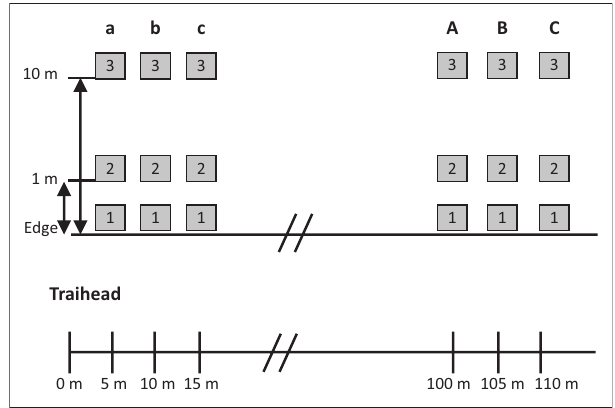
FIGURE 2: Experimental design of vegetation transect survey conducted in the Silvermine section of the Table Mountain National Park in order to investigate the distribution of invasive plants. Three 1-m 2 quadrats, each represented by a grey square, were sampled along a 10-m line transect. This technique was repeated at 5 m (a, b and c) and 100 m (A, B and C) from the trailhead. At both of these locations, transects were established at the edge of the trail (1), 1 m into the matrix (2) and 10 m into the matrix